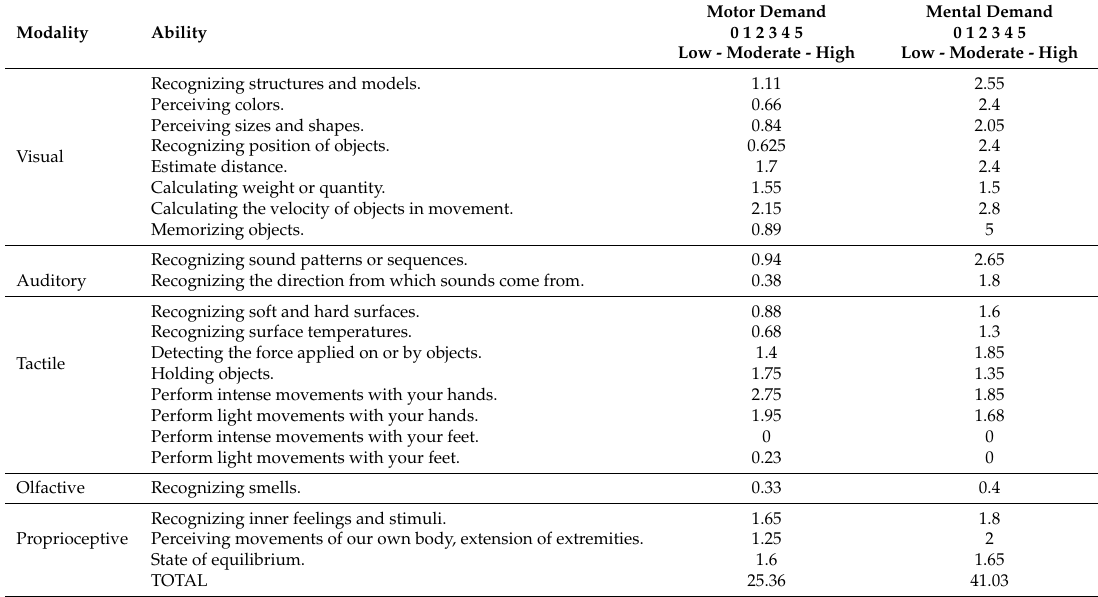
Table 5. Mean for the abilities and demands of SIBMER version V2.